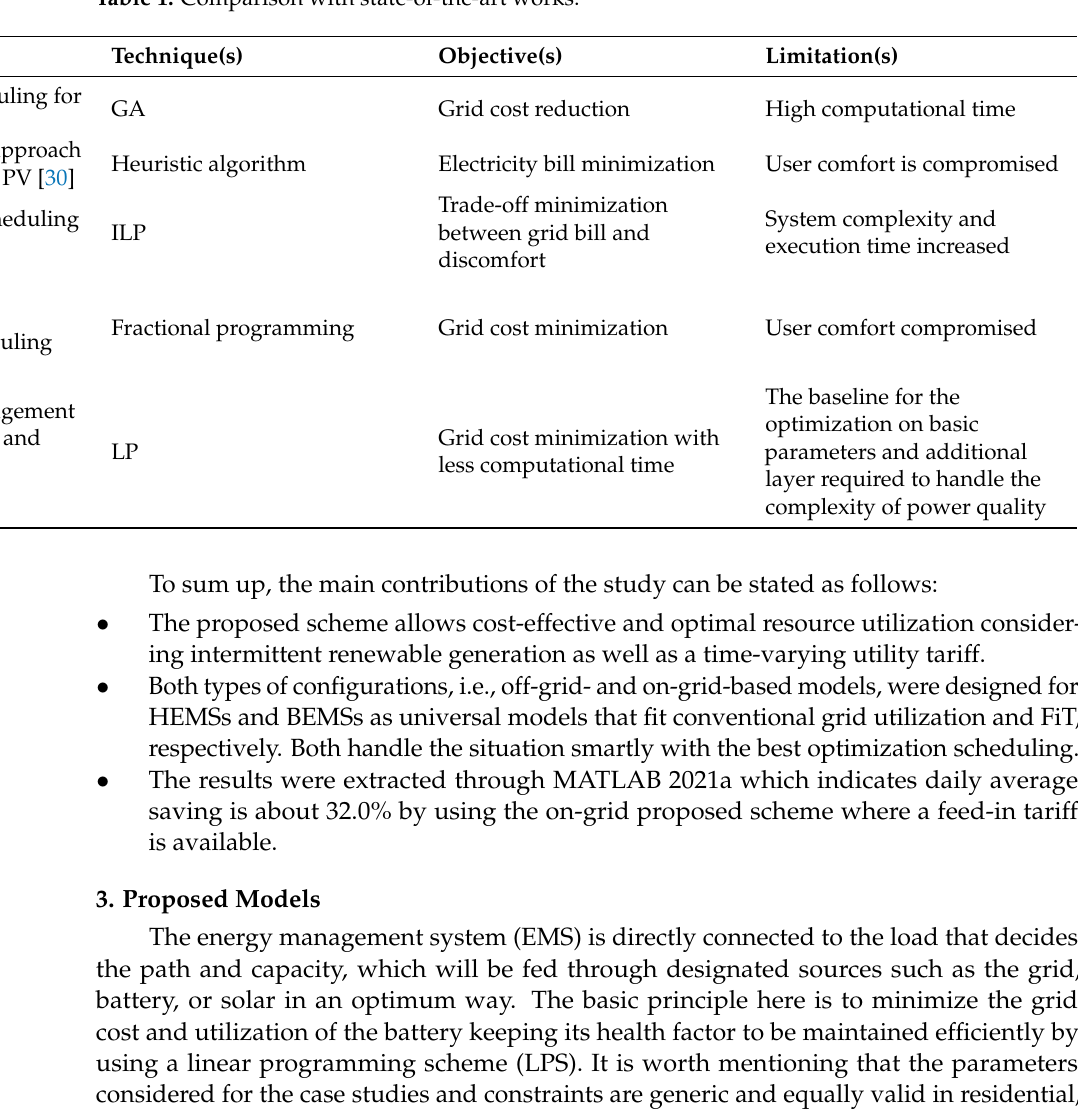
Table 1. Comparison with state-of-the-art